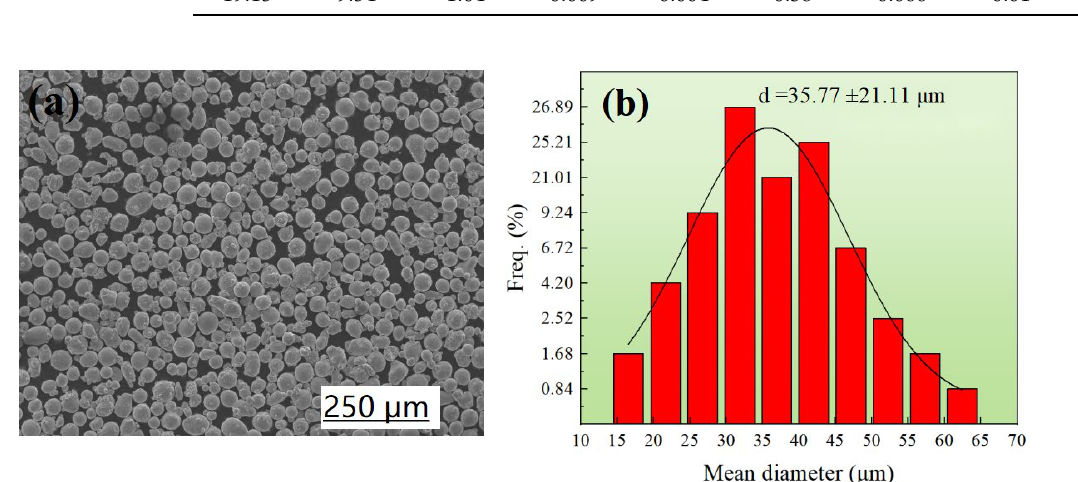
Figure 1. ( a ) SEM image of the particles in the 304L SS powder and ( b ) the normalized particle size distributions.